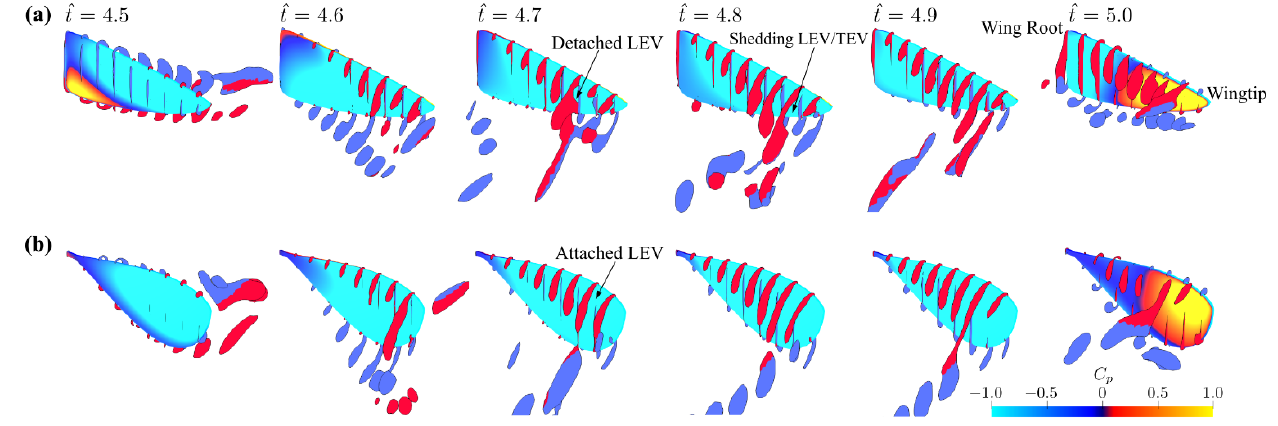
Figure 11. Flow evolution at different time instances for (a) 𝑟̂ 1 = 0.4 and (b) 𝑟̂ 1 = 0.6.